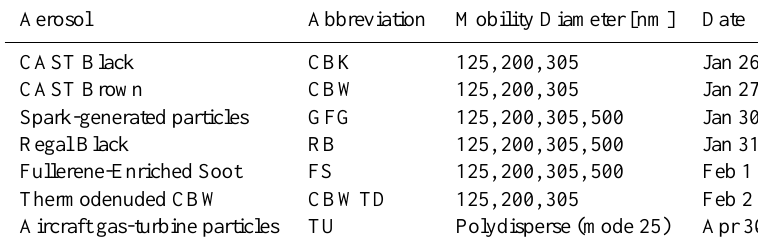
Table 1. Summary of samples, sizes measured, and experimental programme.